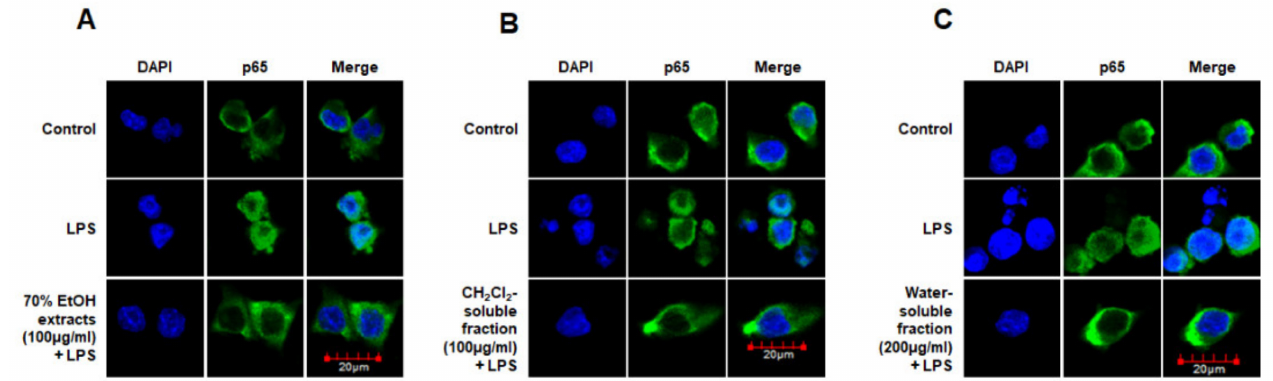
Figure 10. Effects of 70% EtOH extract ( A ) and its CH 2 Cl 2 - ( B ) and water-soluble fractions ( C ) on NF- κ B localization in BV2 cells. Cells were pretreated for 3 h with the indicated concentrations of this extract and its fractions, and then stimulated for 1 h with LPS (1 µ g/mL). The method used to perform the immunofluorescent analysis is described in detail in the Materials and Methods section. Control means an untreated control